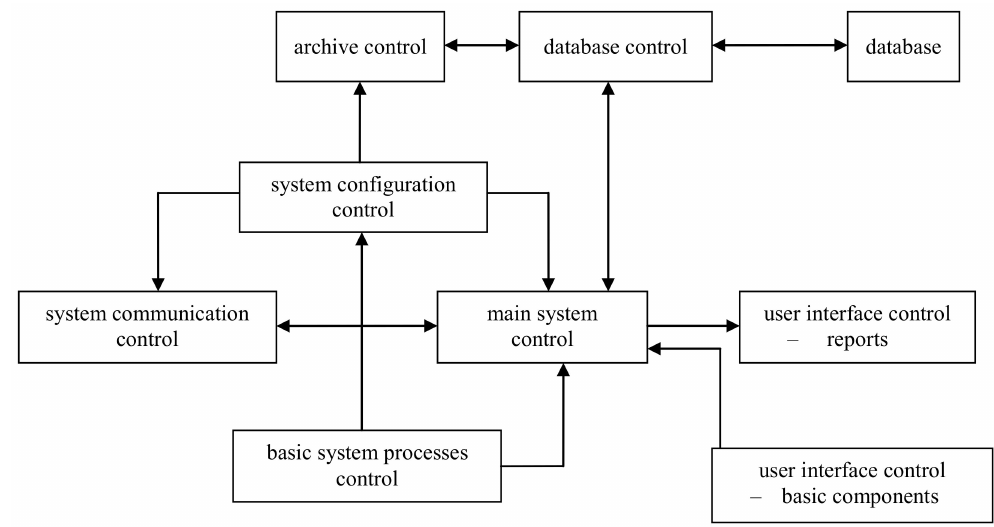
Figure 5. Design of the surface computer together with the